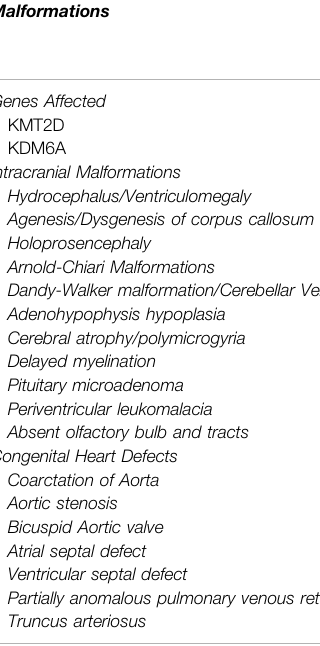
TABLE 1 | Intracranial malformations in patients with molecularly con fi rmed Kabuki Syndrome and associated congenital heart defects.